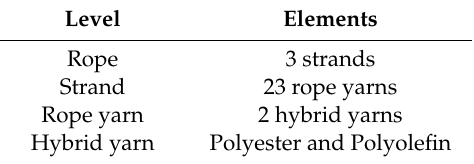
Table 2. Rope construction displaying the elements and material properties of the test